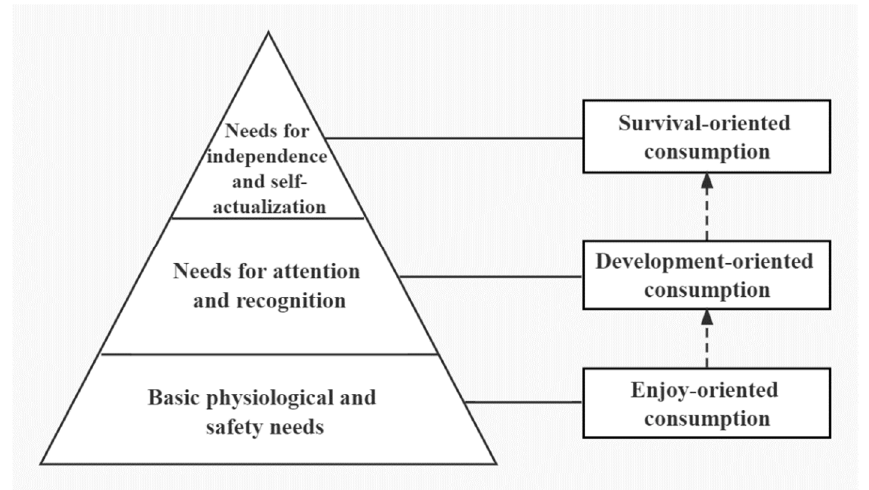
Figure 2. Maslow’s hierarchy of needs and consumption classification.